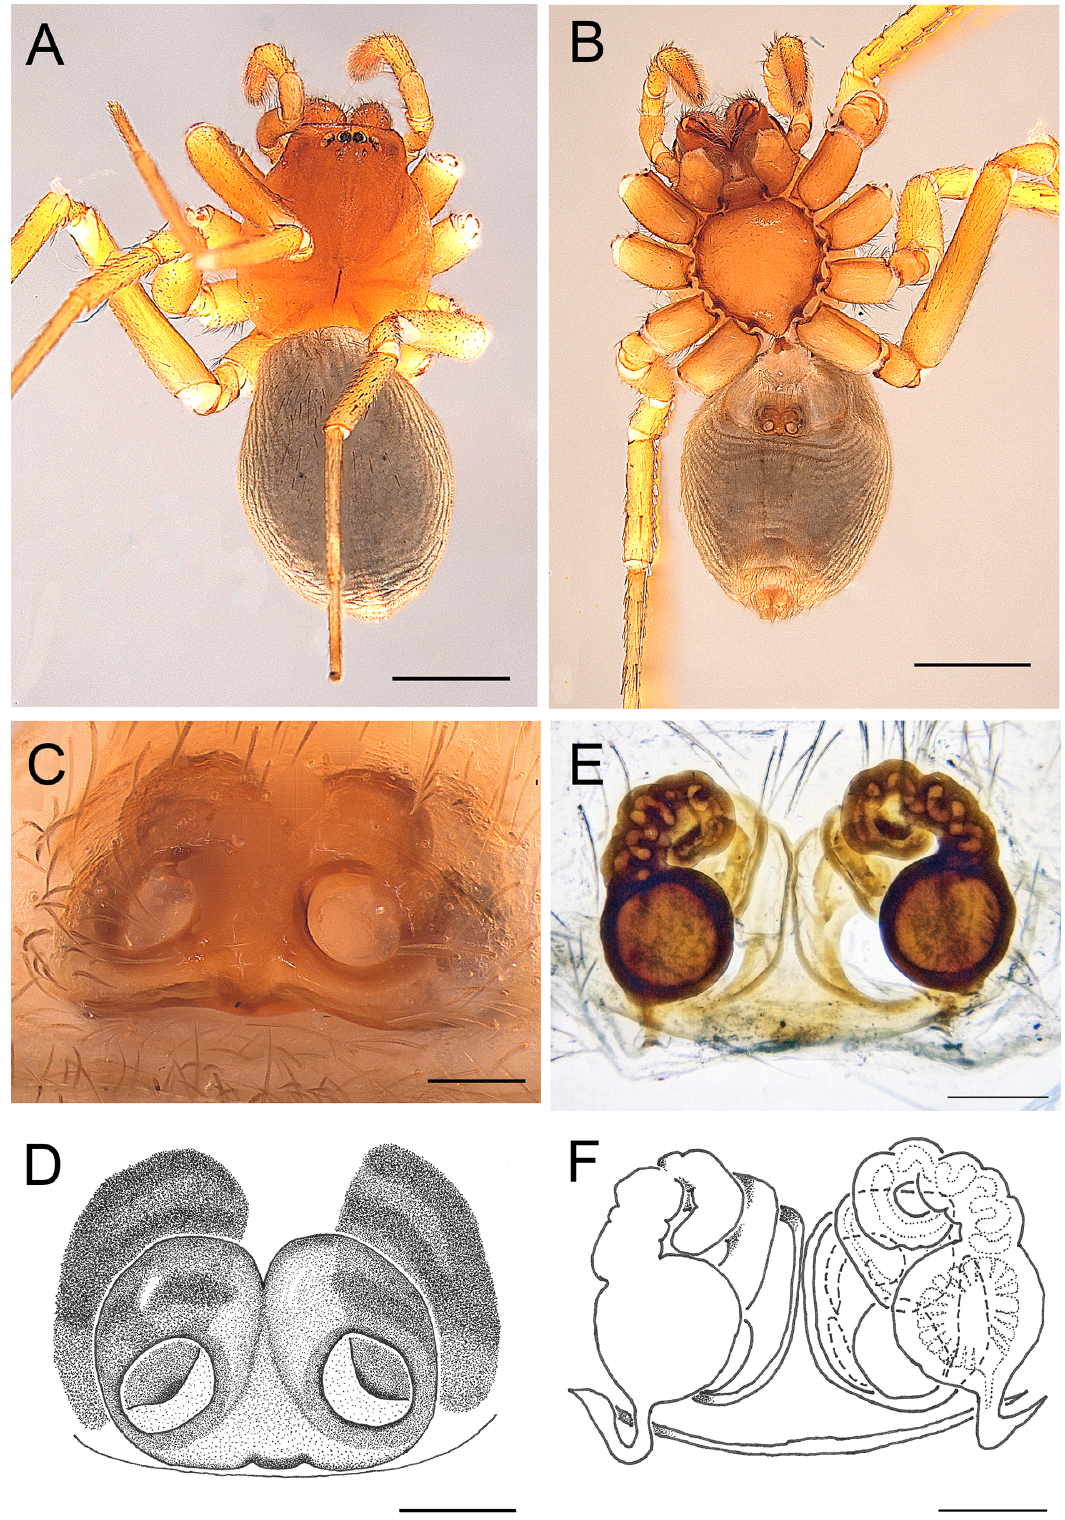
Fig. 31. Andromma prosopion sp. nov., ♀, holotype (BE_RMCA_ARA.Ara 221315). A . Habitus, dorsal view. B . Same, ventral view. C–D . Epigyne, ventral view. E–F . Same cleared, dorsal view. Scale bars: A–B = 1 mm; C–F = 0.1